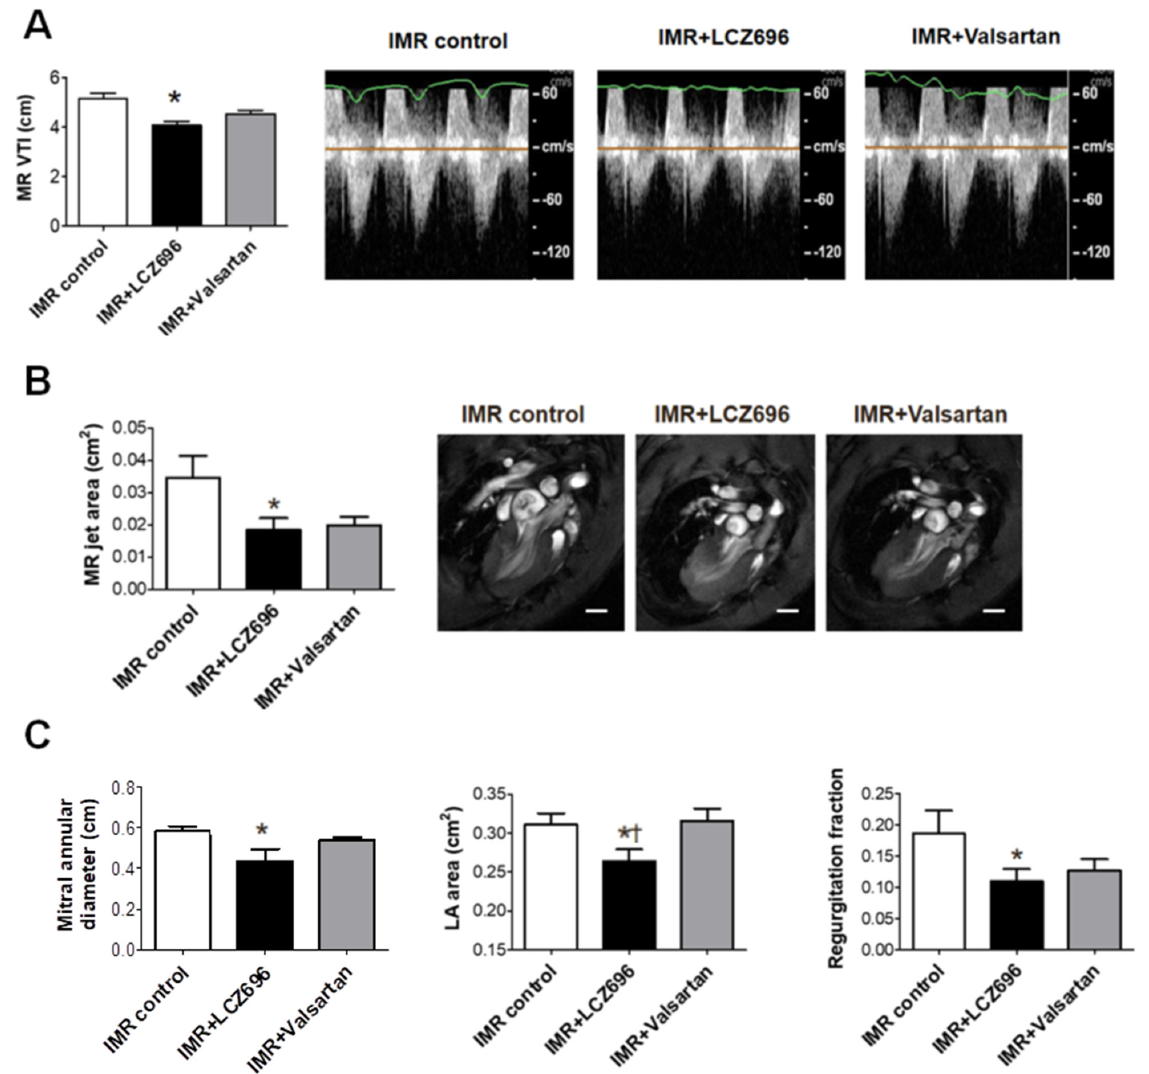
Figure 5. ( A ) Comparison of representative images from continuous-wave Doppler echocardiograms among the three groups at 6 weeks after the MI and a quantitative graph of MR VTI measurement. ( B ) Representative 3-chamber view images from cardiac MRI and a quantitative graph, which shows comparisons of MR jet area among the three groups. Scale bar = 3 mm. ( C ) Mitral annular diameter, left atrium (LA) area and regurgitant fraction were significantly lower in the LCZ696 group compared with the control group. The valsartan group was not significantly different from the control group. IMR indicates ischemic mitral regurgitation; VTI, time velocity integral; LA, left atrium. * p < 0.05 for differences from the control group. † p < 0.05 for differences from the valsartan group.